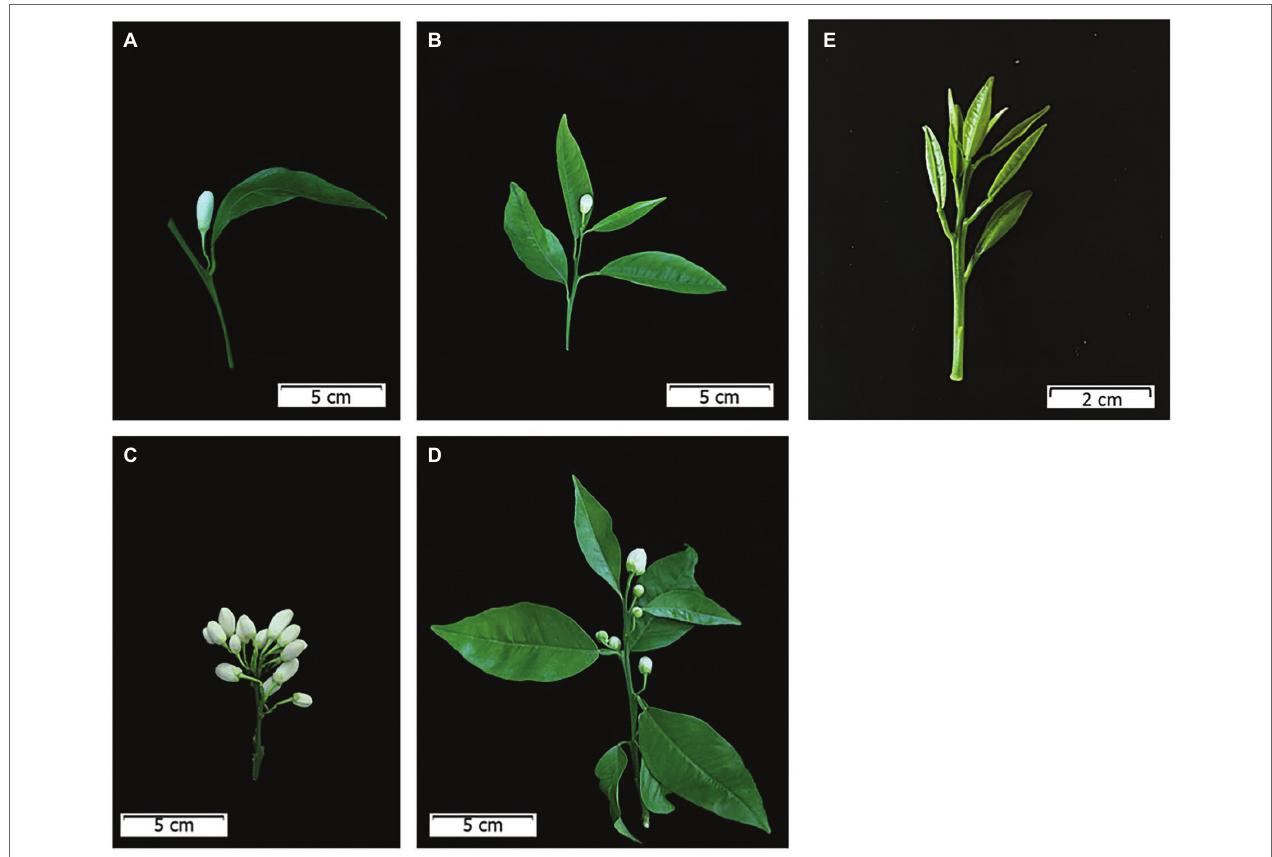
FIGURE 2 | Type of shoots in Citrus . (A) Single-flowered leafless shoot; (B) single flowered leafy shoot; (C) multiflowered leafless shoot; (D) multiflowered leafy shoot; (E) vegetative